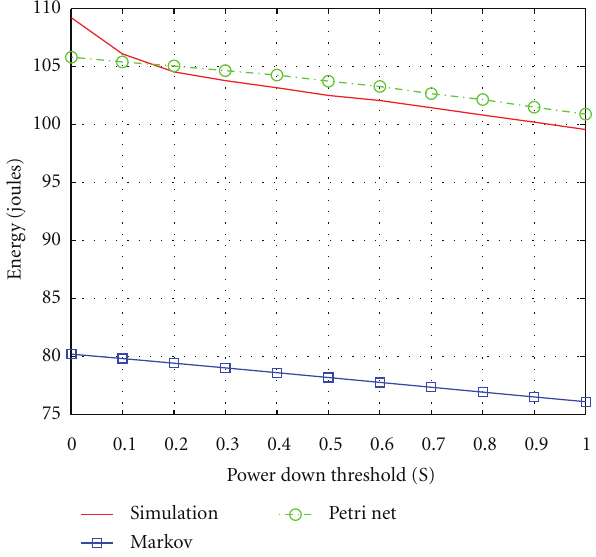
Figure 11: Simple system model of node in wireless sensor network. Table 6: Δ Energy (Joules) estimates ( P ow e r Up De lay = 10 sec- onds).